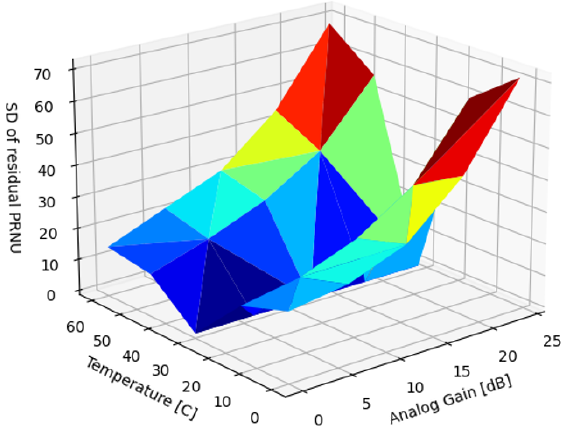
Figure 21. Residual SD of PRNU, multi-reference